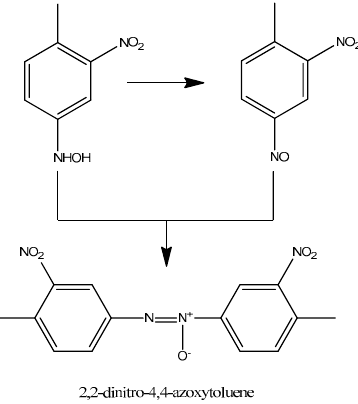
Figure 6. Formation of 2,2-dinitro-4,4-azoxytoluene [44].